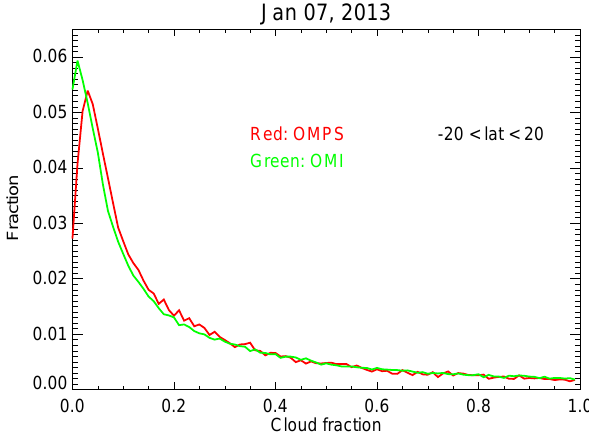
Figure 5. Probability density functions of OMPS and OMI effective cloud fractions for the